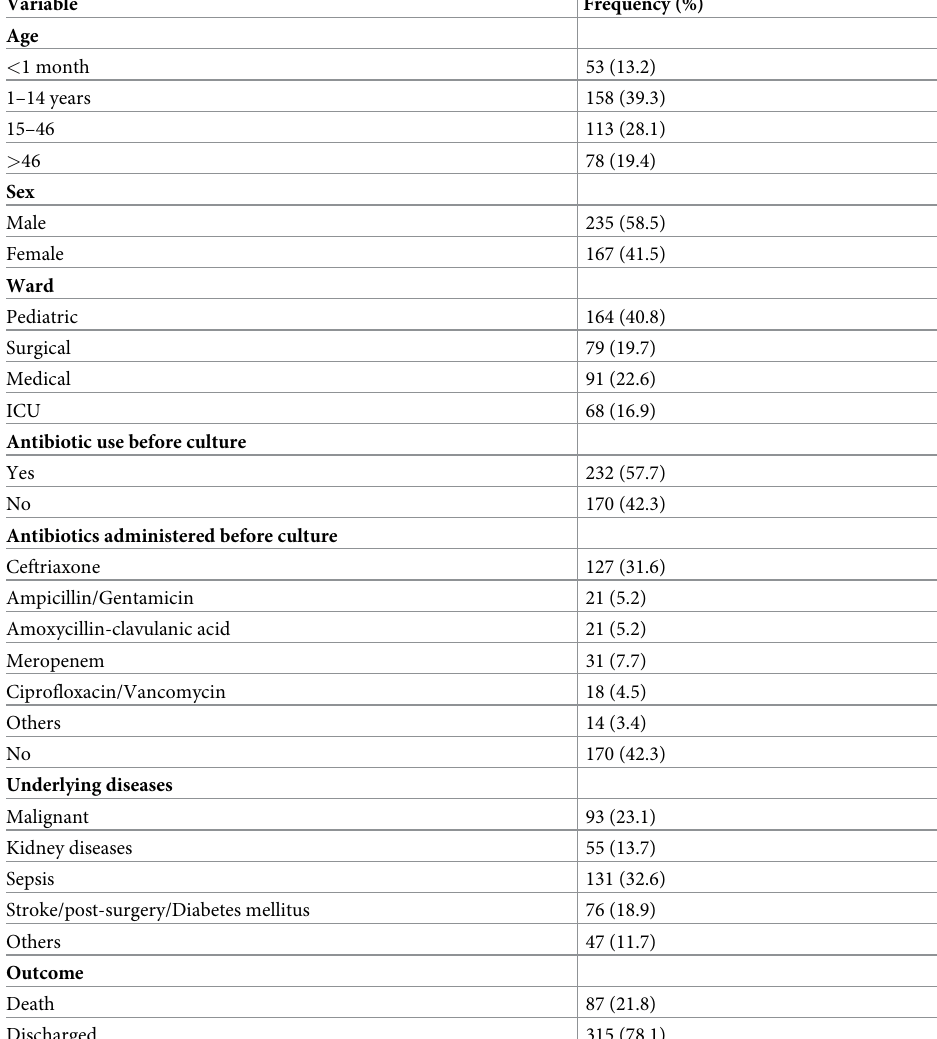
Table 1. Demographic and clinical characteristics of study